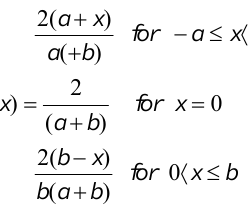
FIGURE 2: Probability Density Function for the Inflation Gap